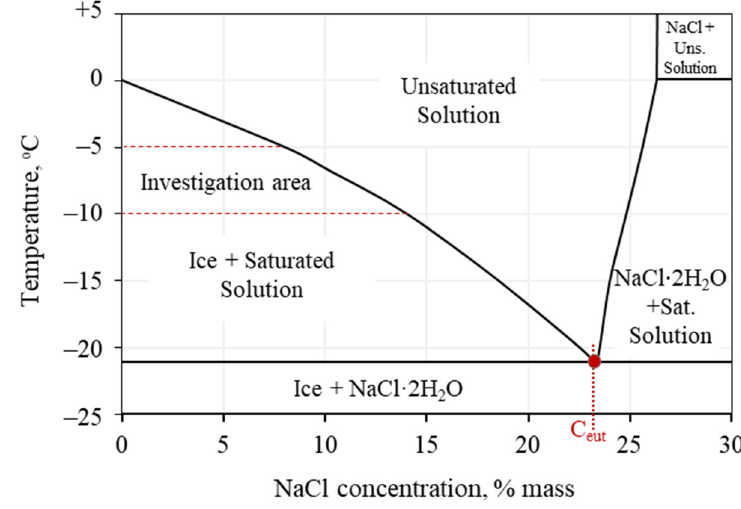
Figure 11. Phase diagram of NaCl solution, modified after [44].